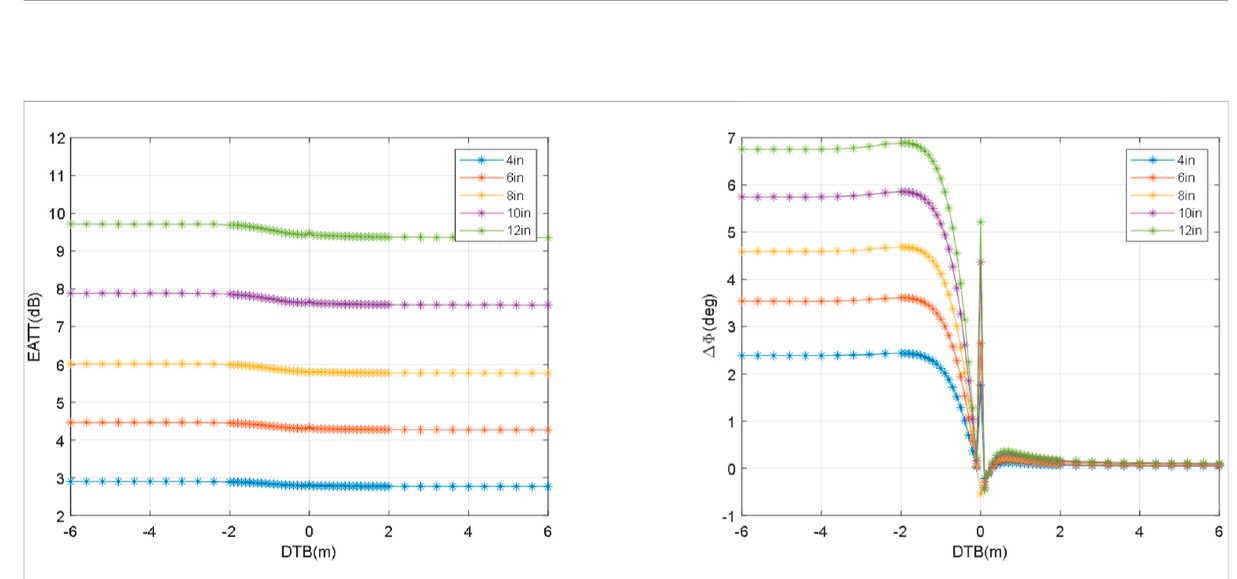
FIGURE 11 Response of the axial receiver at different spacings between the two receiving